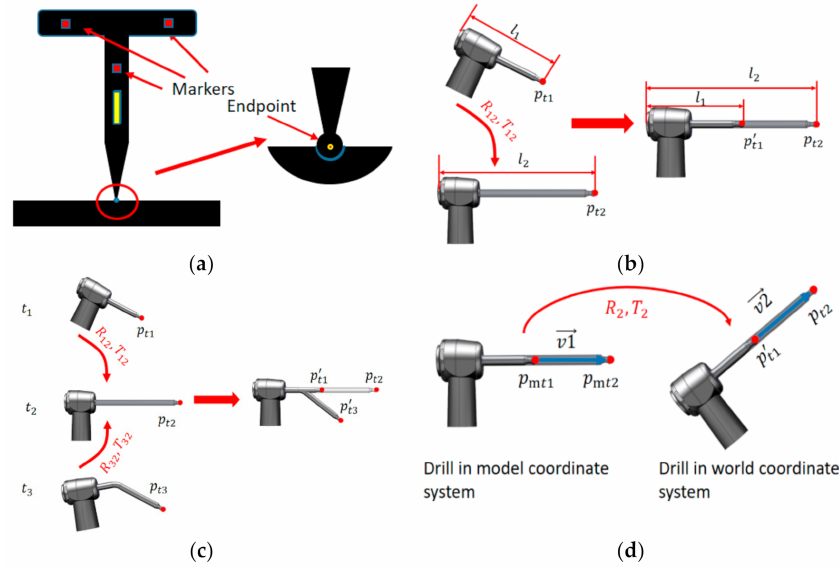
Figure 6. Schematic diagram of implant surgical instrument calibration ( a ). Endpoint calibration, ( b ) axis calibration algorithm based on short and long ball drills, ( c ) three calibration algorithms based on short, long, and bending ball drills, and ( d ) two calibration algorithms based on short and long ball